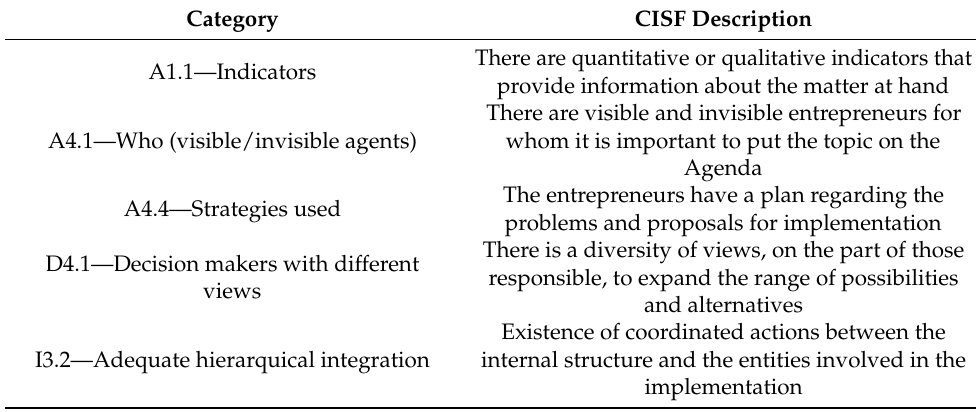
Table 2. Some Examples of Categories and their